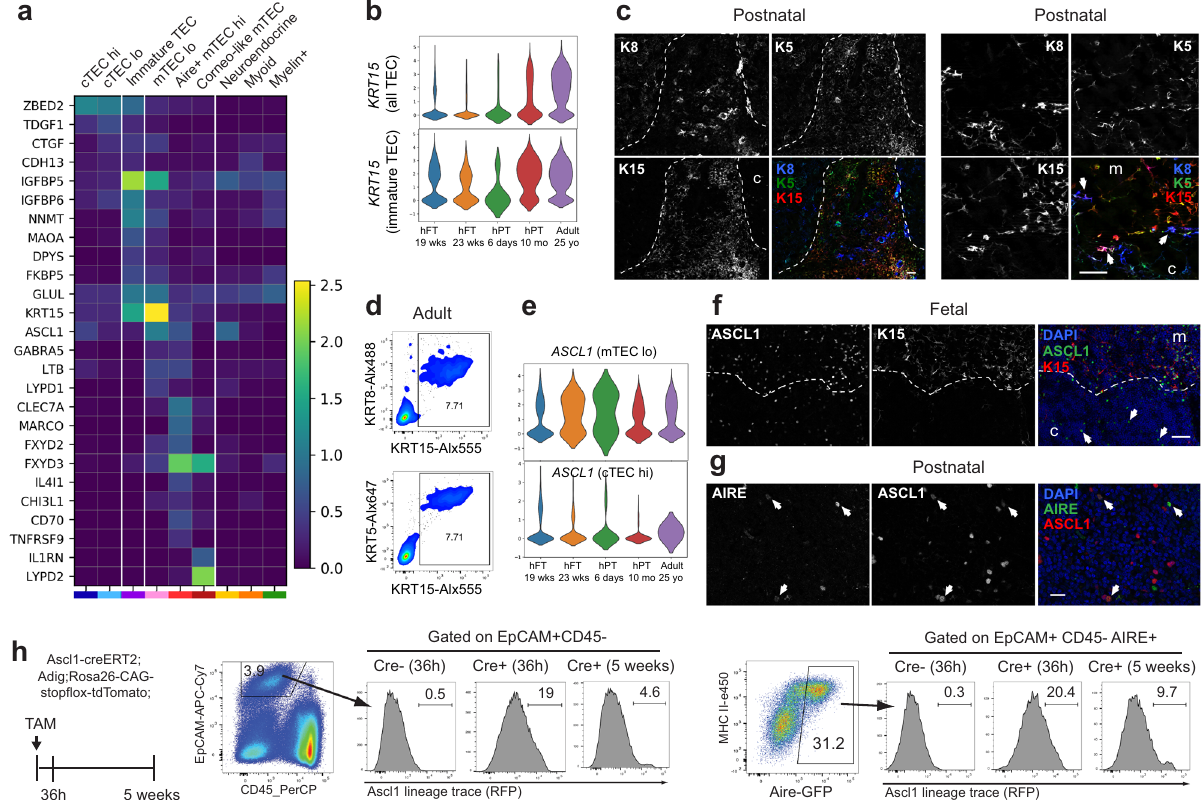
Fig. 4 Identi fi cation of new TEC markers. a Heatmap showing the expression of newly identi fi ed marker genes in each epithelial cluster. b Violin plots of KRT15 expression in all TECs and in immature TECs. c Immuno fl uorescence analysis of KRT15 expression in postnatal human thymus. KRT8 (blue) and KRT5 (green) are also included as markers of TECs. Dotted line indicates the separation between cortex (c) and medulla (m). A higher magni fi cation showing that KRT15 is expressed at low levels in KRT8 + KRT5 + immature TECs and at higher level in mTECs is shown in the right panels. Medullary area is marked with “ m ” while cortical area is marked with “ c ” . Arrows point to examples of KRT8 + KRT5 + immature TECs. Scale bars, 50 μ m. d Flow cytometric analysis of KRT15, KRT8, and KRT5 expression in TECs isolated from adult thymus. e Violin plots of ASCL1 expression in mTEC lo and cTEC hi. f Immuno fl uorescence analysis of human fetal thymus demonstrating that ASCL1 (green) is expressed in KRT15 hi (red) mTECs. ASCL1 expression is also detected in the cortex of fetal thymus (arrows). Dotted line marks the separation between cortex (c) and medulla (m). Scale bar, 50 μ m. g Immuno fl uorescence analysis of postnatal thymus showing that expression of ASCL1 (red) in the thymic medulla partially overlaps with AIRE (green). Scale bar, 20 μ m Arrows point to double positive mTECs. h Ascl1-lineage trace (RFP) in TECs at 36 h ( n = 3 mice) and 5 weeks ( n = 3 mice) post- tamoxifen (TAM) treatment. Percentage of RFP-labeled Aire + TECs is shown. Expression of RFP in TECs from Cre-negative mice is also presented as negative control ( n = 7 mice). Staining in c , f , and g was repeated at least three times with similar